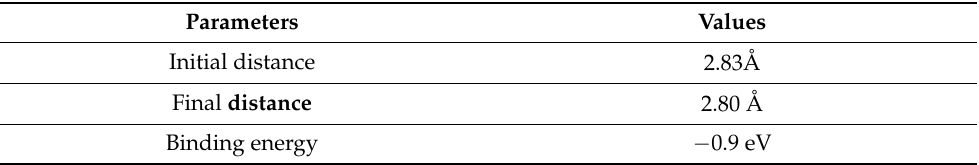
Table 2. Values of the electronic and structural parameters obtained for the interface of interaction for the best-ranked docking complex formed by binding site target residues (Lys340) interacting with atoms from the PHF— 18 F-THK5105 +